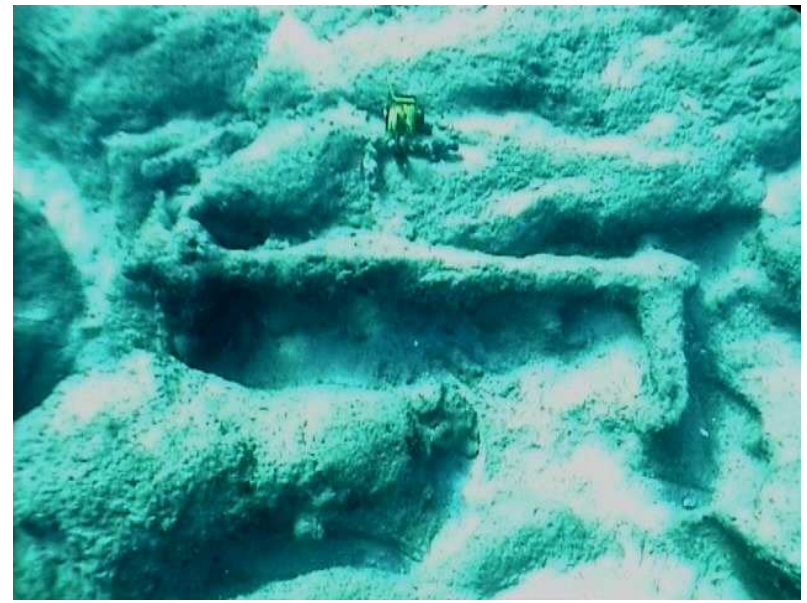
Figure 10. Anomaly number 3 found at a depth of 9 m on the seabed. The artifact is 5th century Byzantine iron anchor.